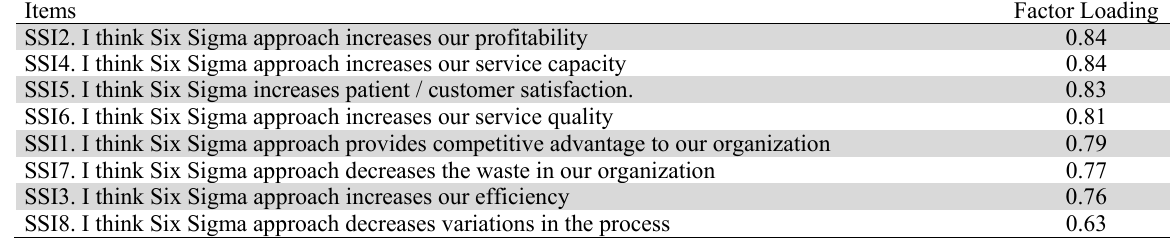
Explanatory Factor Analysis Result of Six Sigma